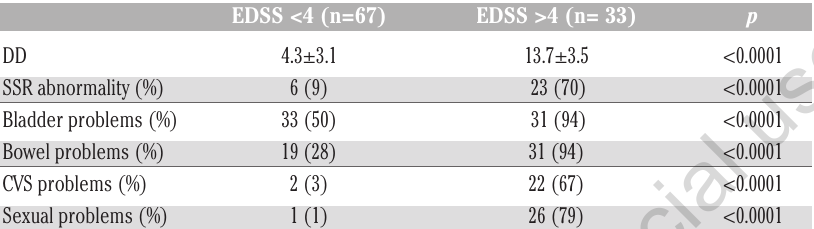
Table 2. Distribution of autonomic dysfunction among the patient